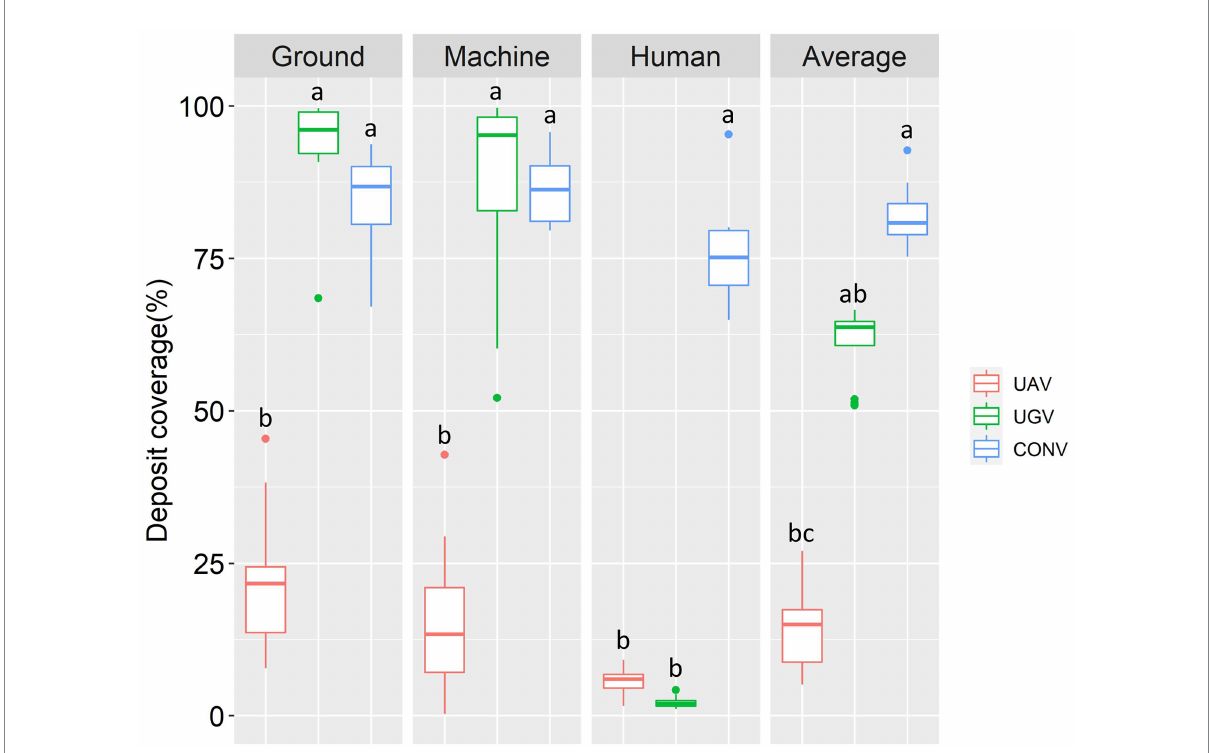
FIGURE 5 The droplet residue on the ground, machine and human body of unmanned aircraft vehicle technique (UAV), unmanned ground vehicle technique (UGV) and conventional manned technique (CONV). Different letters in the same column indicate significant differences at the p < 0.05 level under ANOVA test with LSD as post hoc test. UAV had 18 biological replicates while UGV and CONV had 13 biological